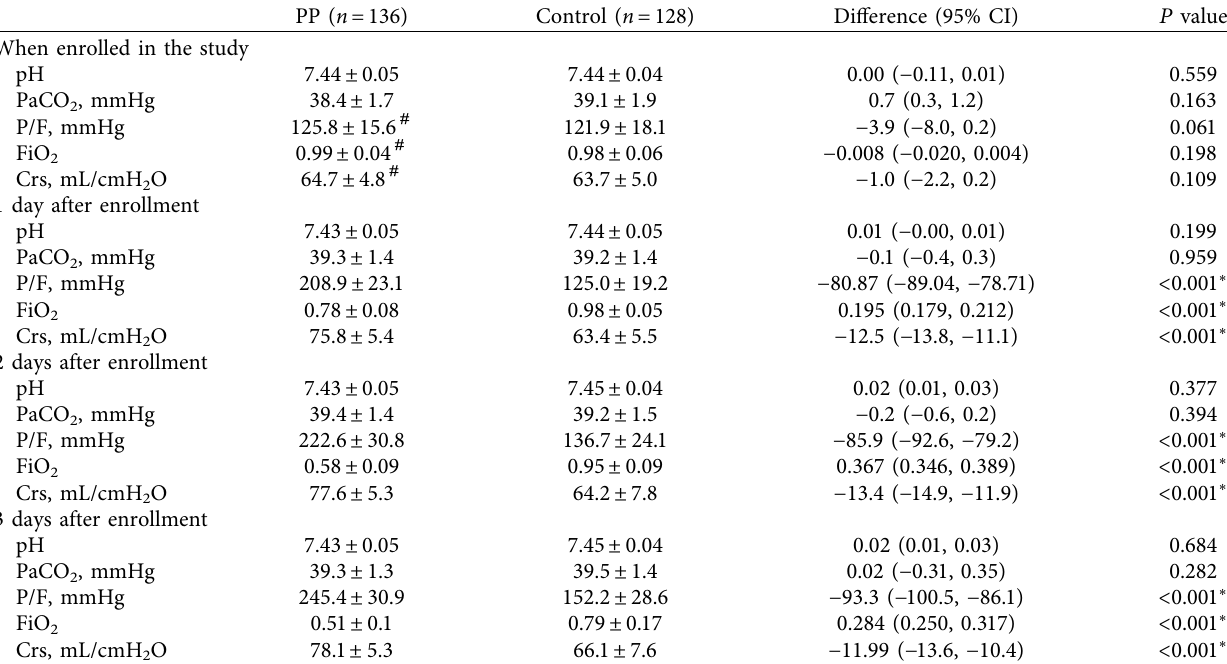
Table 2: Changes in arterial blood gas and Crs.